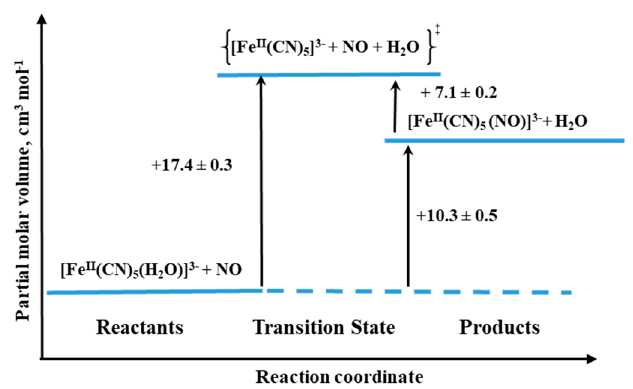
Figure 18. Volume profile for the reversible coordination of NO to [Fe II (CN) 5 H 2 O] 3 − according to Reaction (6) [39] .